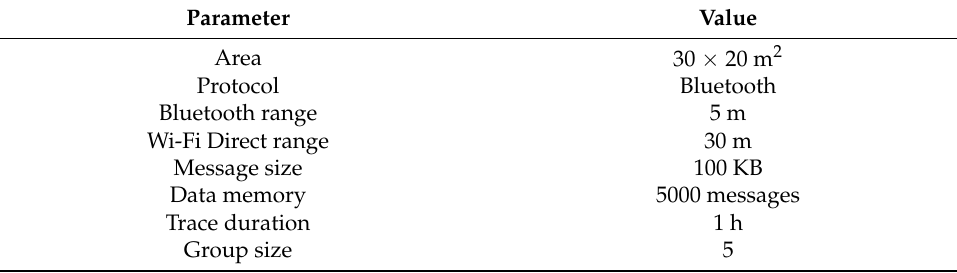
Table 2. Input parameters for the Bluetooth and Wi-Fi traces.